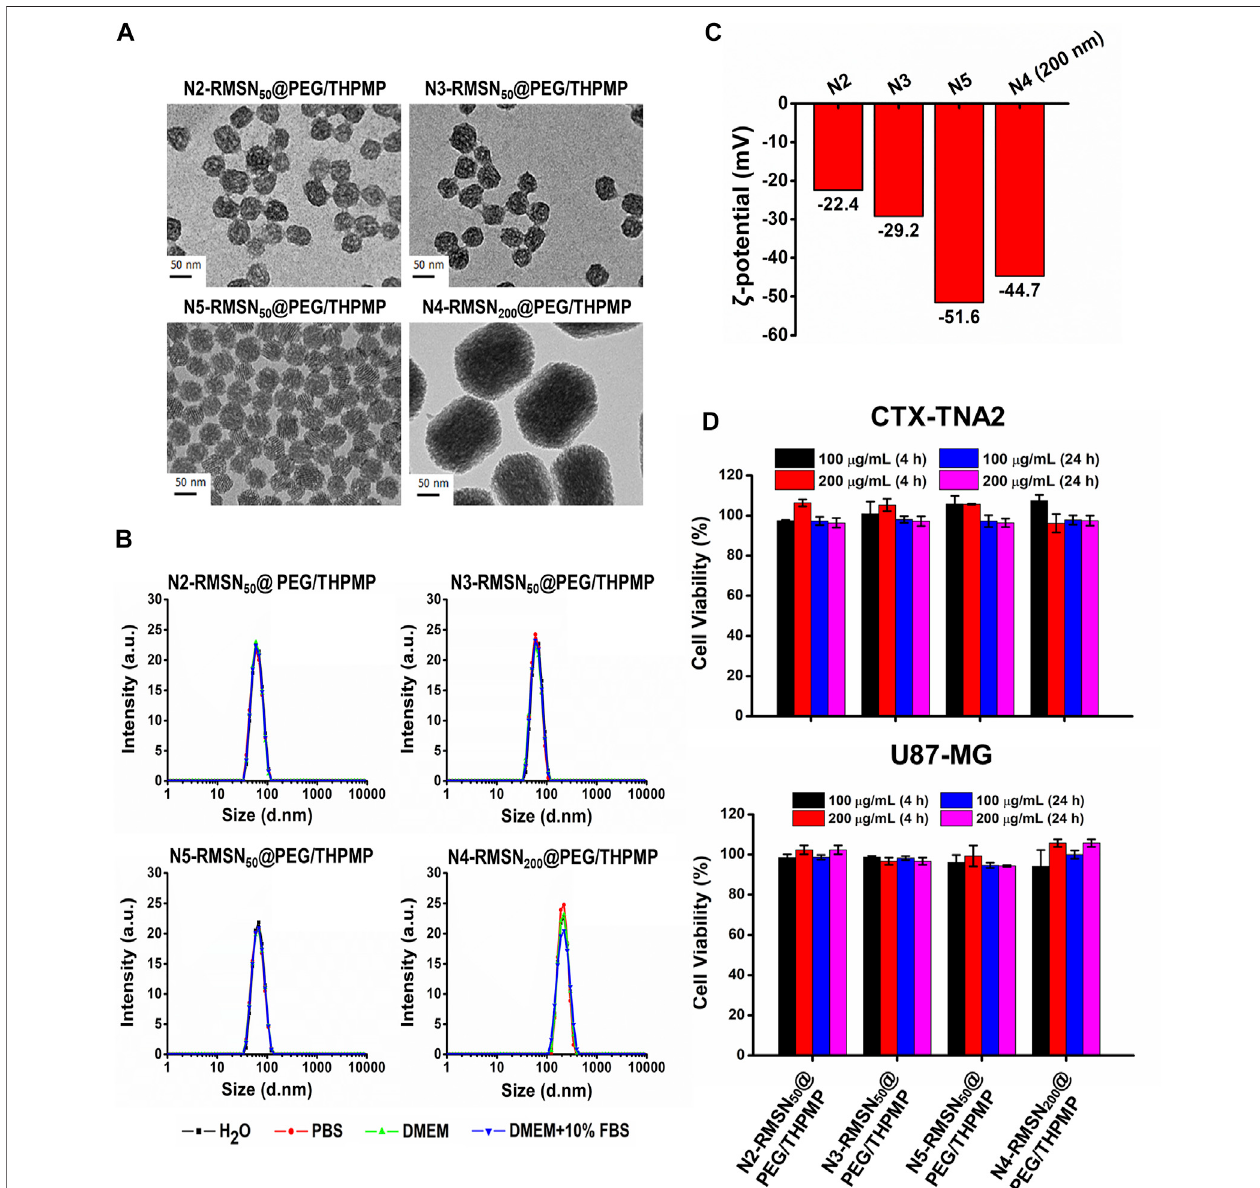
FIGURE 3 | Physical characterizations and cytotoxicity of four different negatively charged RITC-conjugated mesoporous silica nanoparticles (RMSNs) with differentsizes(50and200 nm). (A) TEMimages.Scalebar=50 nm. (B) DLSand (C) zetapotentialmeasurements. (D) Cytotoxicityassay.CTX-TNA2andU87-MGcells were cultured with different concentrations (100 and 200 μ g/ml) of various types of RMSNs for 4 and 24 h under 10% serum-containing media condition. Cell viability was detected with an MTT assay.